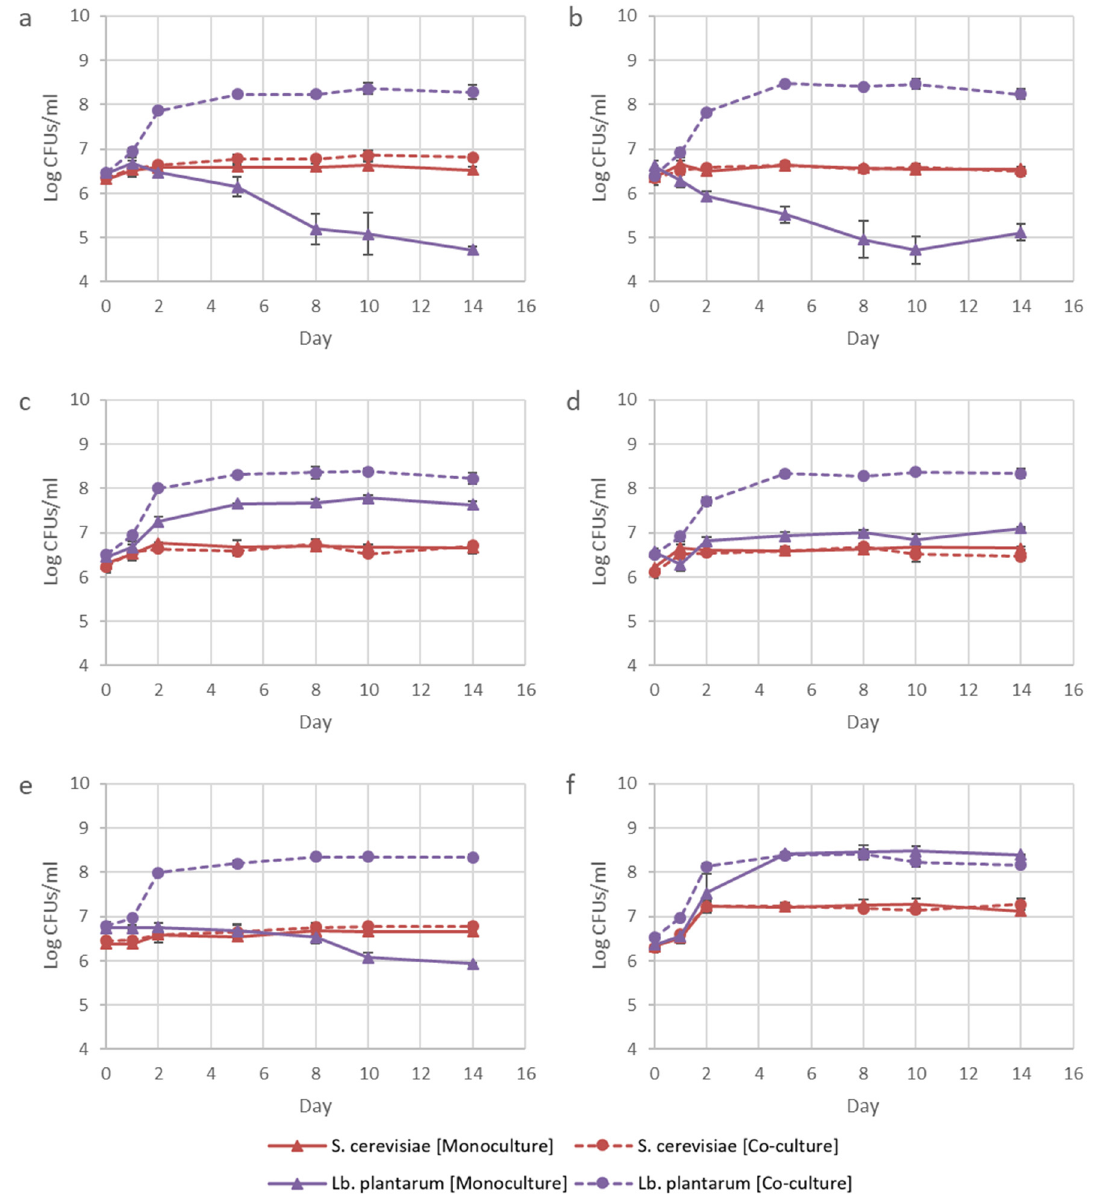
Figure 2. Log CFUs / mL for S. cerevisiae strain BY4742 ∆ thi4 and Lb. plantarum strain IWBT B038 over the 14-day incubation period for the Lys-Ile ( a ), Lys-Ala ( b ), Lys-Val ( c ), Lys-Met ( d ), Lys-Ile-Ala-Val-Met ( e ), and control ( f ) treatments. Data shown are means of triplicates, with error bars representing standard deviation.